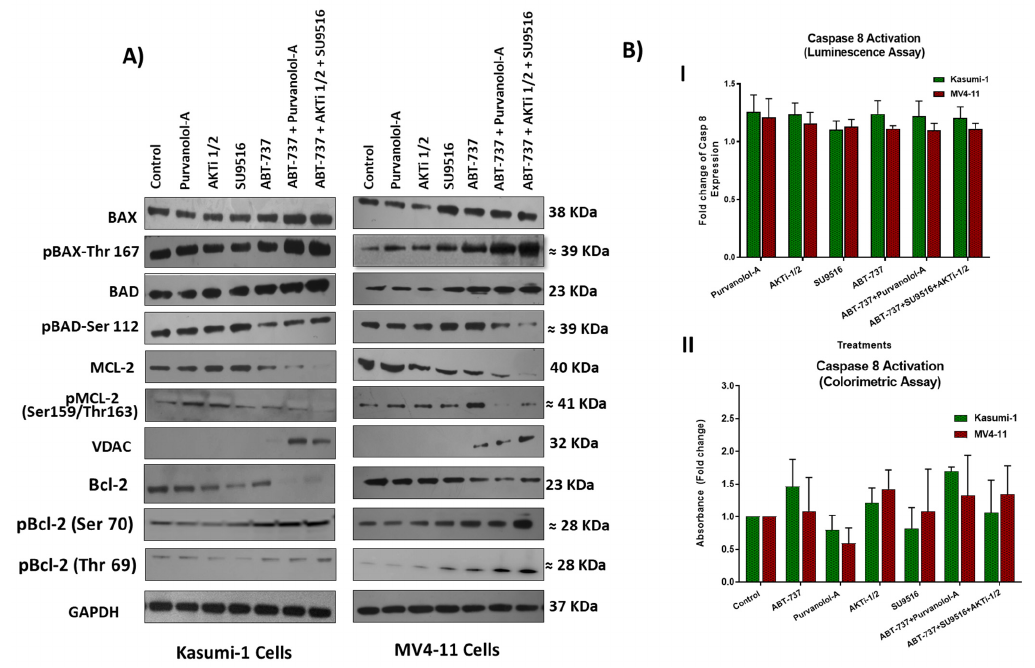
Figure 5. ( A ) Western blot analysis of pro-apoptotic and anti-apoptotic proteins and their phosphorylated versions in Kasumi-1 and MV4-11 cell lines following 72 h treatment as single agents and as a combination. GAPDH was used as a loading control. ( B ) Caspase-8 activity in cell lysates from Kasumi-1 and MV4-11 cells treated for 72 h as single agents and combination treatments of ABT-737 + Purvalanol-A and ABT-737 + AKTi-1/2 + SU9516 or single agents. Caspase activity was detected using either the caspase-8 assay colorimetric kit ( I ) where protein concentrations were quantified first, then the activity of caspase-8 was assessed, or using caspase-8 activity luminescence assay ( II ). The absorbance or luminescence signal was detected using Synergy HTX Multi-mode Micro-plate reader. Caspase-8 activity was presented as fold increase in activity of the corresponding control. All the results shown are representative of three independent